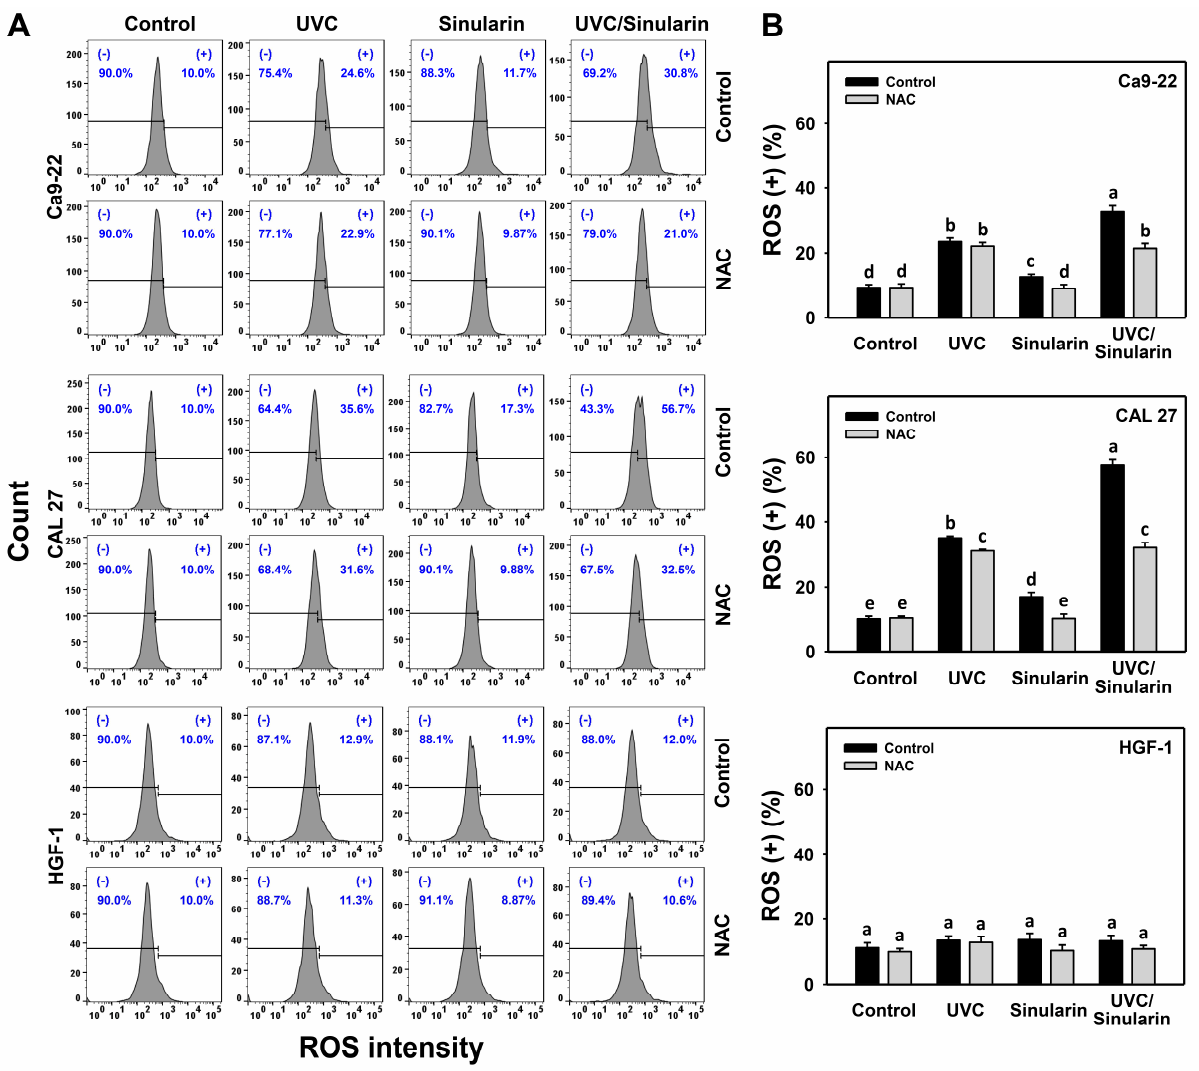
Figure 5. ROS expressions of UVC and/or sinularin treatments. Following the NAC preincubation (5 mM for 1 h) or not, the cells were arranged into four kinds of treatments: the control (0.1% DMSO in medium), UVC, sinularin, and UVC/sinularin for 24 h. The UVC and/or sinularin conditions were 12 J/m 2 , 2 µ M and 10 J/m 2 , 3 µ M for oral cancer cells (Ca9-22, CAL 27), and 12 J/m 2 , 3 µ M for normal cells (HGF-1) for 24 h, respectively. ( A , B ) Patterns and quantifications for ROS analysis. (+) indicates ROS-positive (%). For the multi-comparisons, the treatments marked without repeated characters (a to e) differ significantly ( p < 0.05). The data were plotted as the mean ± SD ( n = 3).